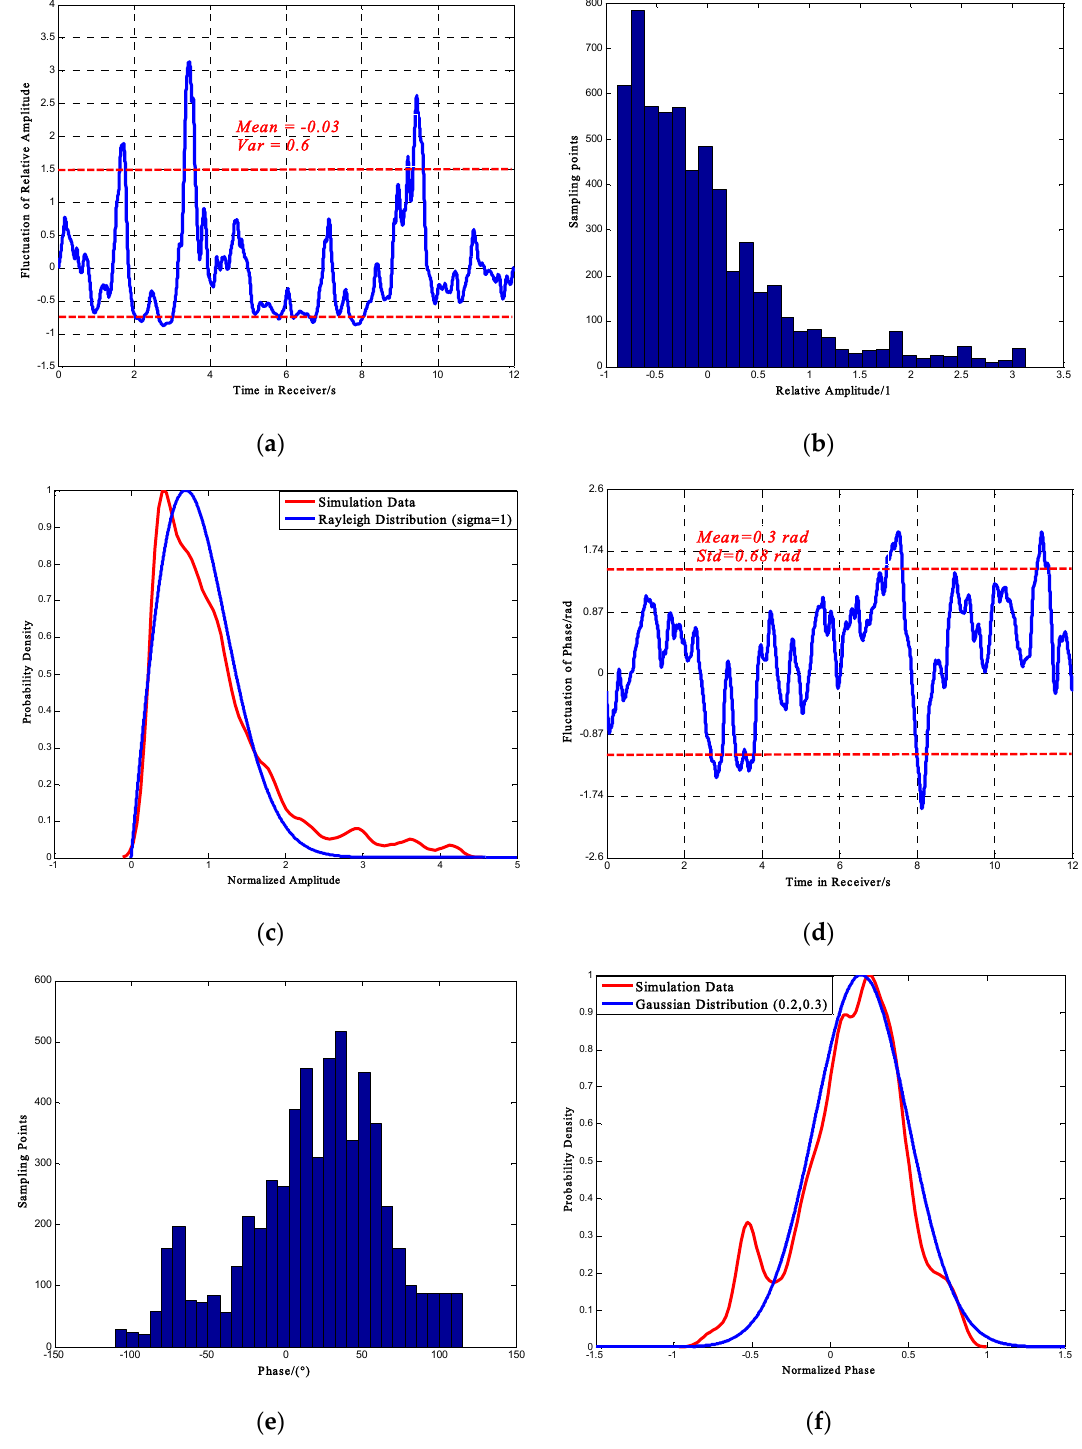
Figure 5. Phase and amplitude for S 4 = 0.808 ( a ) Relative Amplitude Fluctuation; ( b ) Distribution of Amplitude Fluctuation; ( c ) Probability Density Curve; ( d ) Phase Fluctuation; ( e ) Distribution of Phase Fluctuation; ( f ) Probability Density Curve.